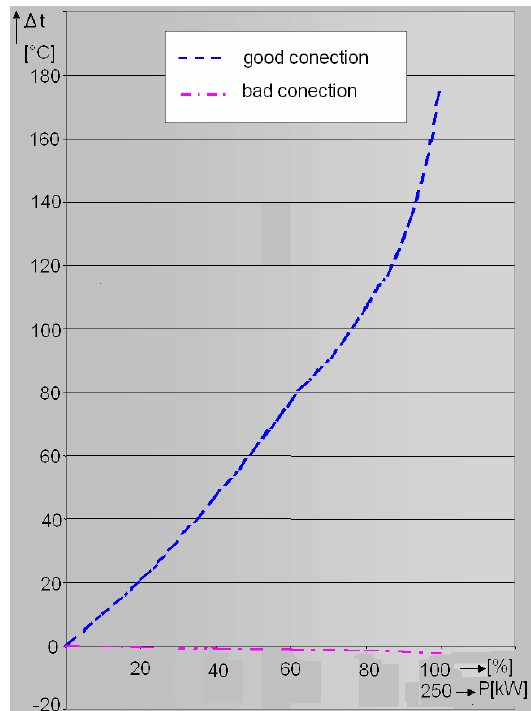
Fig 4. Relationship between temperature rise amount of connection and feeder line upon power